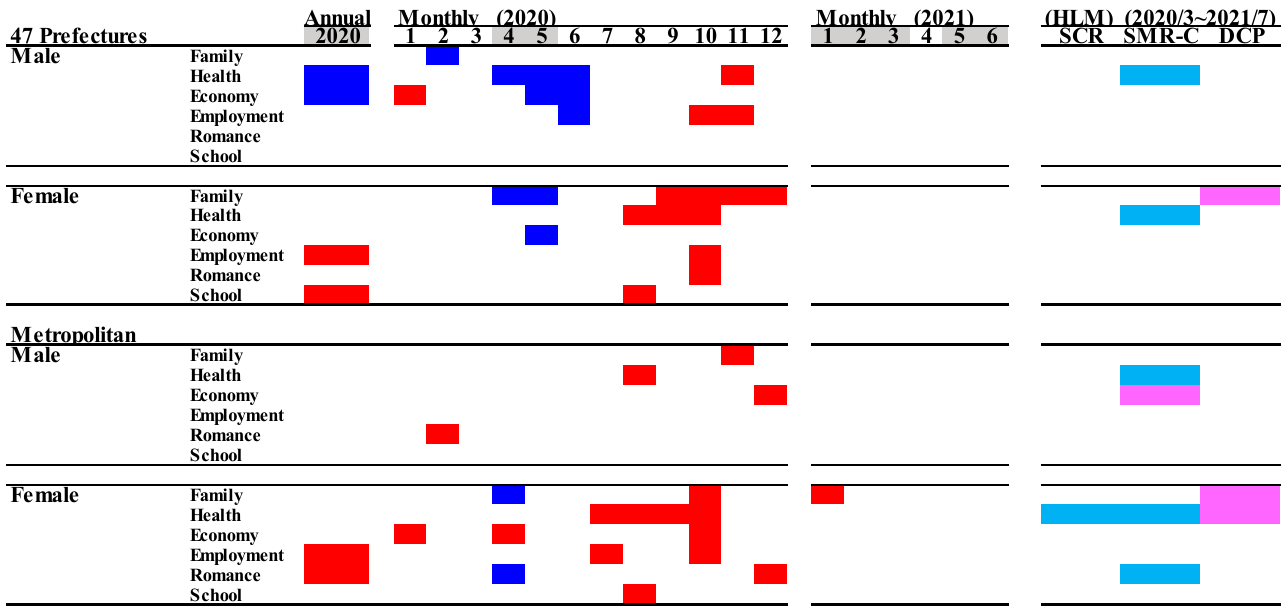
Figure 11. Comparison of annual and monthly SMR-S caused by suicidal motives during the pandemic period to average SMR-S of the same month during the pre-pandemic period, and impact of COVID-19 pandemic on SMR-S in Japan. Blue and red columns indicate significant decreasing and increasing suicide mortality using a linear mixed-effects model with Tukey’s multiple comparison ( p < 0.05). Light blue and red columns indicate significant decreasing and increasing factors against SMR-S using hierarchical linear model with robust standard error ( p < 0.05). SMR-S: standardised suicide mortality per 100,000 people. SCR: standardised infection with COVID-19 per 100,000 people. SMR-C: standardised mortality caused by COVID-19 per 100,000 people. DCP: during COVID-19 pandemic.